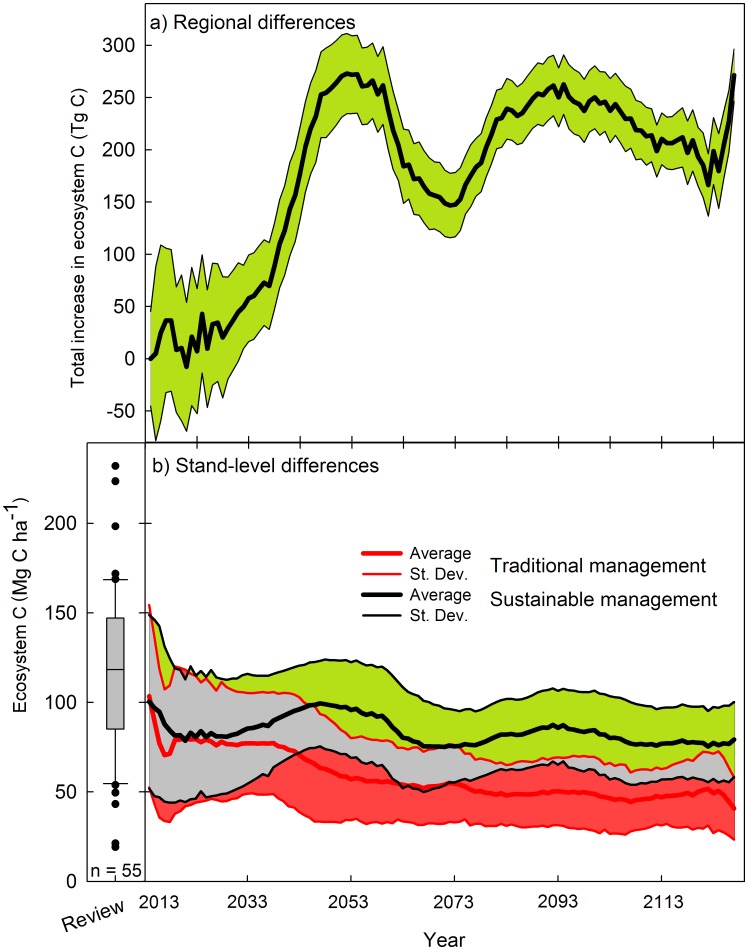
Total carbon gains when switching from current traditional intensive forestry to sustainable forest management at an annual rate of 10% of total area dedicated to Chinese-fir plantations (panel A).Ecosystem carbon density in Chinese fir plantations under current intensive management (red lines), and sustainable management (green lines) (panel B). Thick lines represent average and color areas represent one standard deviation. The grey area indicates values of ecosystem C that can be achieved by either sustainable or traditional management plans. The box-plot in the bottom-left summarizes the values obtained from a review of 55 published peer-reviewed papers on carbon stocks in Chinese fir plantations (see Material S1 for the complete reference list).